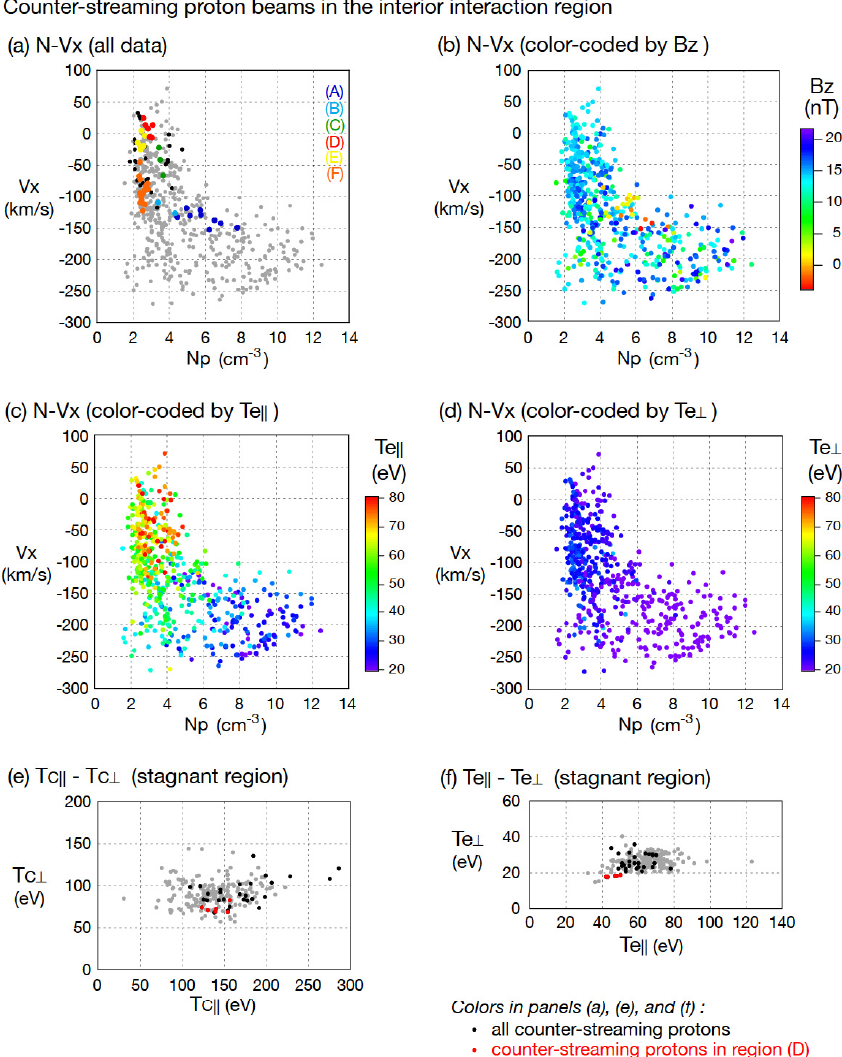
Fig. 9. Scatter plots in the interior interaction region between 07:16–09:10 UT. In Panels (a) , (e) , and (f) , data for the counter-streaming protons are shown as black and red points, the latter of which show those obtained in region (D). In Panel (a) relation between N P and V X is presented, where gray points correspond to all other data obtained in the interior interaction region, and data in regions (A–F) are also plotted. The upper-right panel (b) shows the same data as shown in Panel (a) but color-coded by B Z . Panels (c) and (d) are color-coded by the parallel and perpendicular temperatures of electrons. In Panels (e) and (f), temperatures of the cold proton component and the electrons are presented, respectively, where gray points correspond to data obtained in the stagnant region ( | V X | < 100km/s).